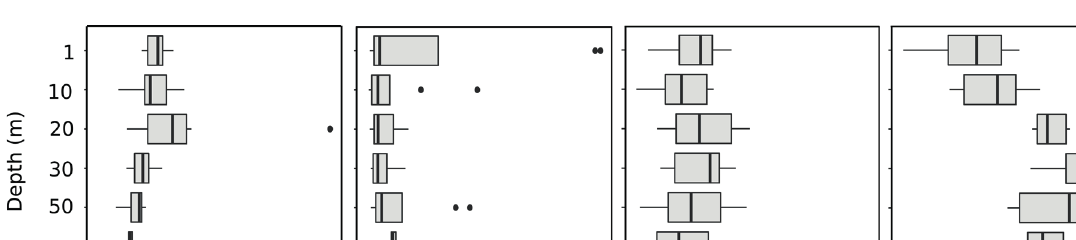
Figure 2 - T-S diagram of the stations performed during the period of maximal precipitation (N1, N2, S1 and S2) and minimal precipitation (N3, N4, S3 and S4). Different sites are displayed using different shapes according to the legend within the